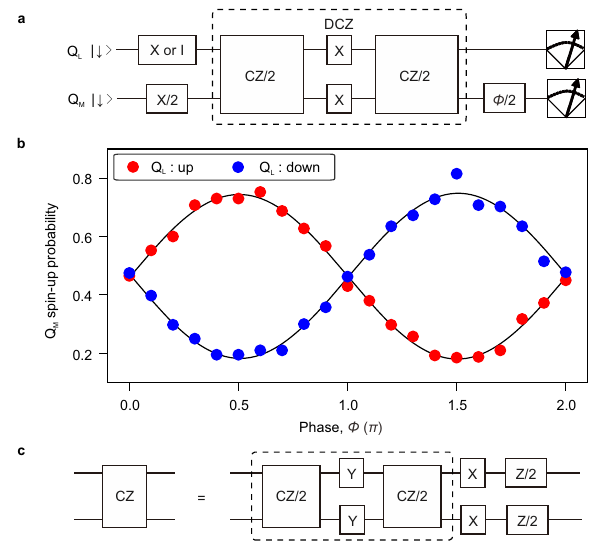
Fig. 4 | Calibration and characterization of CZ gate. a Quantum circuit used for calibrating the controlled-phase accumulation in Q M during the DCZ gate. b AccumulatedphaseonQ M intheDCZgateoperationwhenQ L ispreparedinspin- down (blue) and -up (red) measured using the circuit shown in ( a ). Here, an unconditional phase accumulation of 0.04 π for Q M is compensated by shifting the phase of the fi nal π /2 rotation 12,13,37 . At the same time, Q L also acquires an uncon- ditional phase of 0.065 π (Supplementary Fig. 7b). We use V tilt =0.012V at the coupled state where J =1.25MHz. c Quantum circuit for constructing the CZ gate from the DCZ gate and single-qubit gates. Here, we use Y gates acting on both